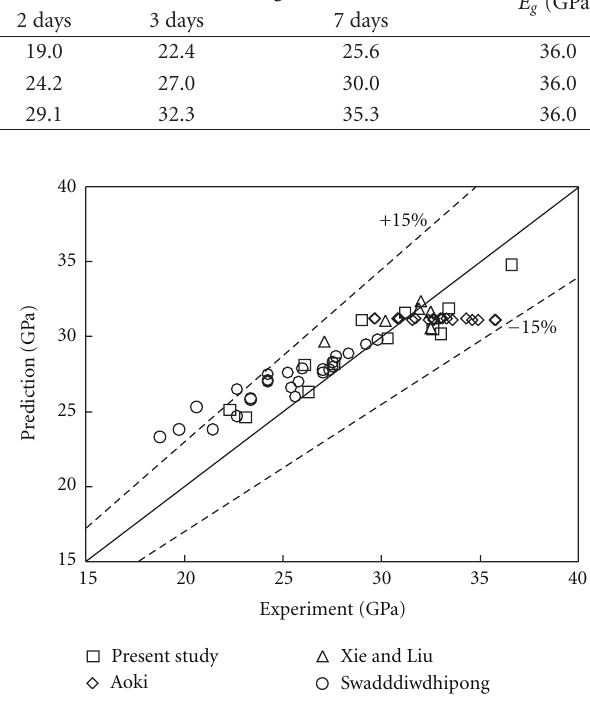
Figure 16: Comparison of experiments and